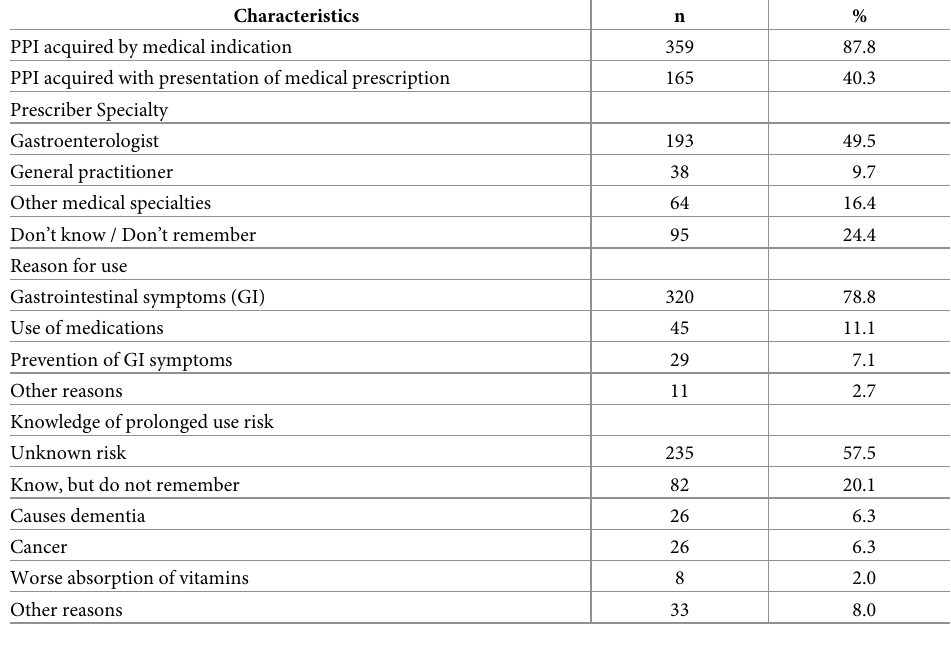
Table 3. Prescription profile of PPIs, motivation for acquisition and knowledge about risks of prolonged use.